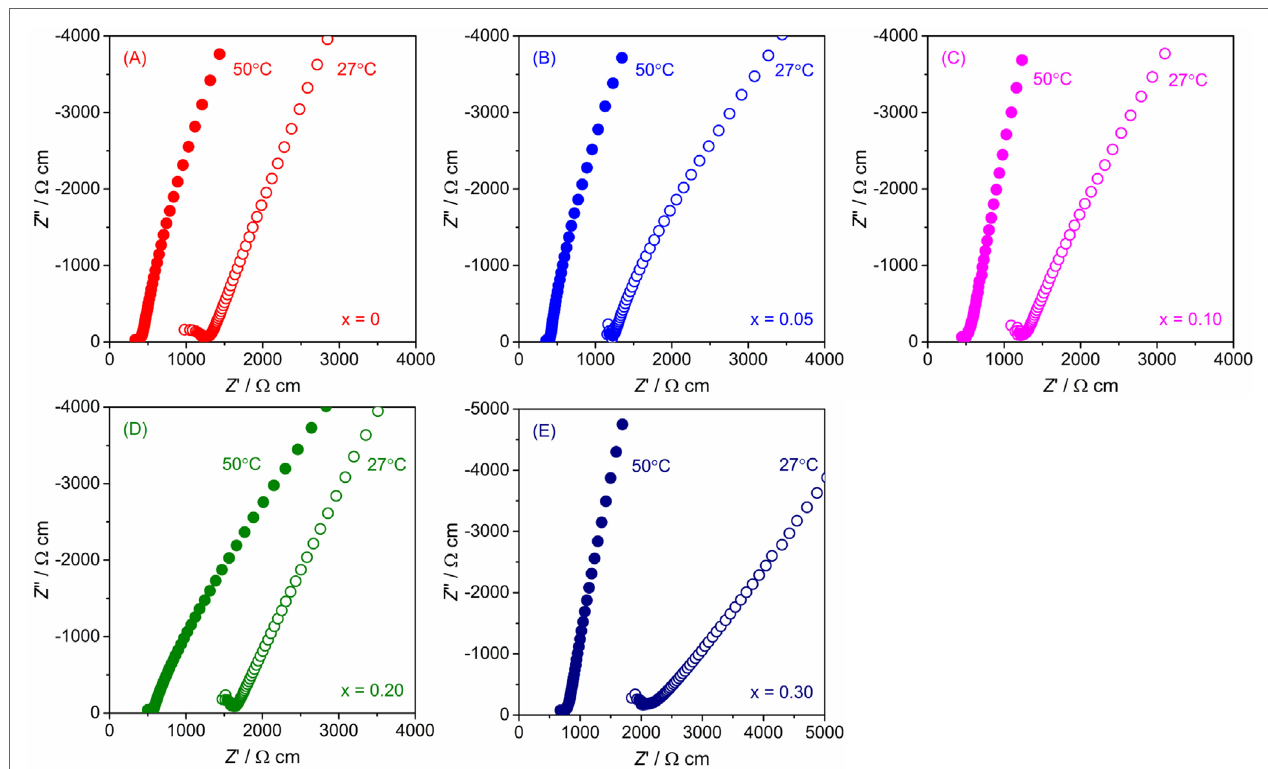
FigUre 6 | nyquist plot of ac impedance for llBZT with different Ba contents x at 27 and 50°c: (a) x = 0, (B) x = 0.05, (c) x = 0.10, (D) x = 0.20, and (e) x = 0.30 .